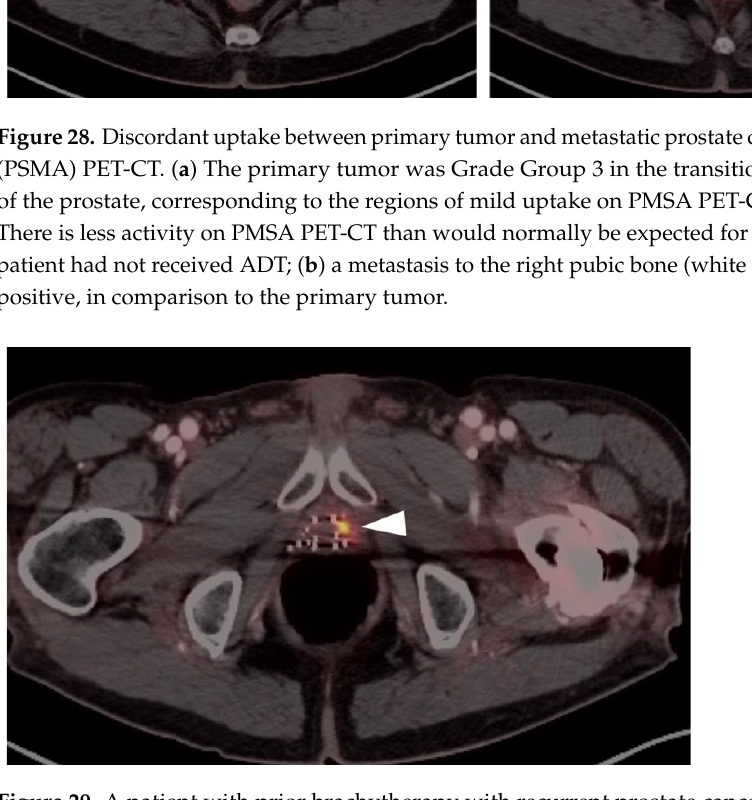
Figure 29. A patient with prior brachytherapy with recurrent prostate cancer in the left lobe of the prostate, shown on PSMA PET-CT. The site of tumor is very small but clearly delineated (white arrowhead). MRI would have had limited utility in this patient because of metal artifact created by the brachytherapy seeds.